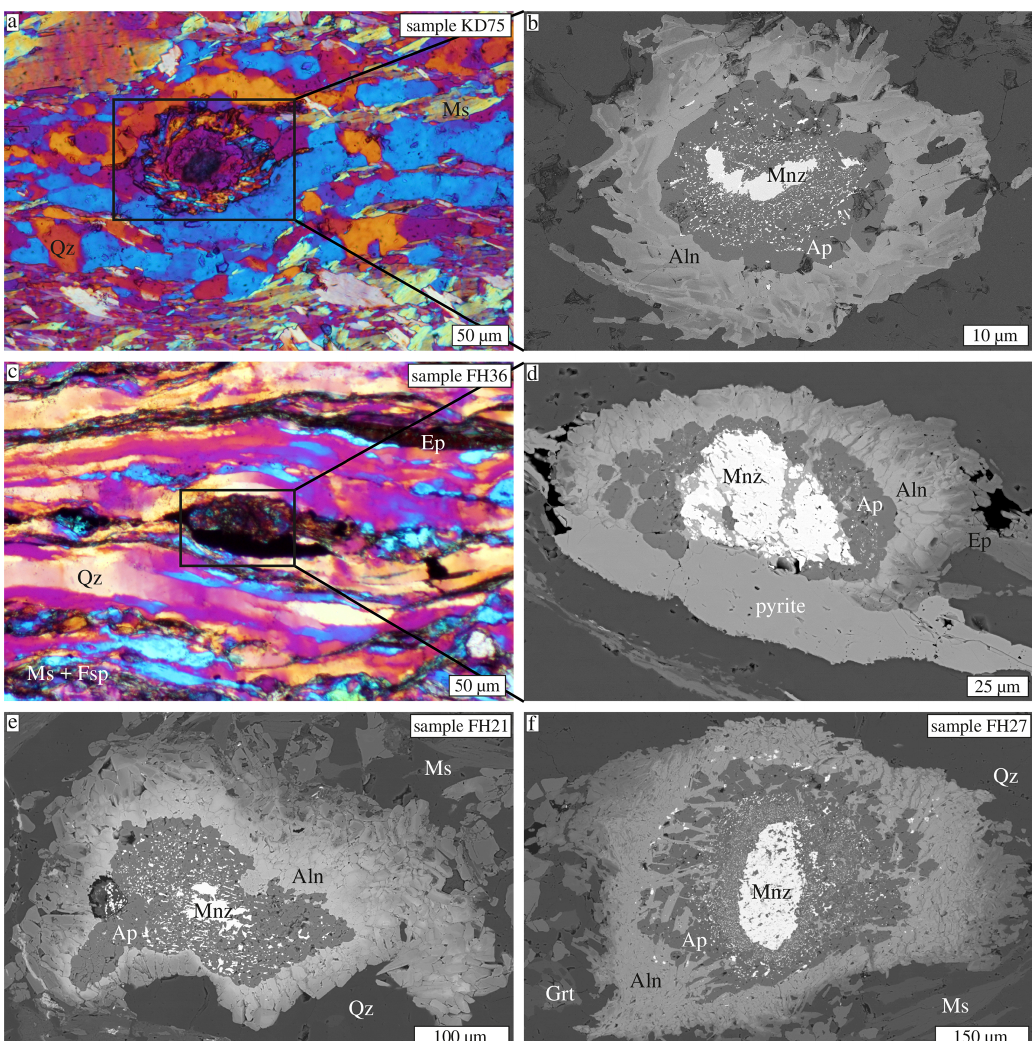
Figure 2. Micrographs of typical corona microstructures around monazite with fluorapatite, allanite and epidote zones. (a) Polarized light micrograph with compensator plate inserted showing corona within mylonitic pegmatite (sample KD75). Note the quartz layers bent around the corona. (b) BSE image of the corona microstructure shown in (a) . (c) Polarized light micrograph with compensator plate inserted showing a corona around monazite in mylonitic pegmatite surrounded by pyrite (sample FH36). (d) BSE image of the corona microstructure shown in (c) . (e, f) Corona microstructures chosen for detailed chemical and microstructural characterization and dating. All abbreviations for mineral names are from Whitney and Evans